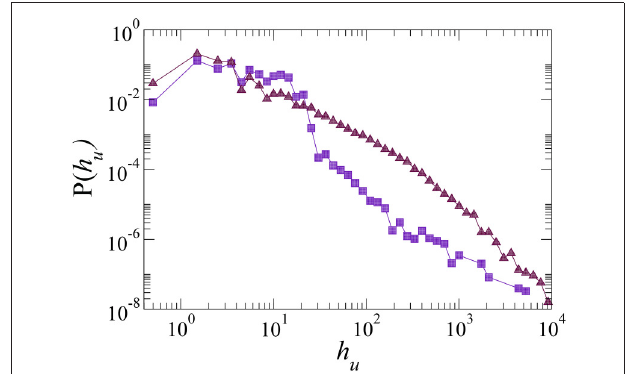
FIGURE 7 | Distribution of ratings in the reviews of EP (dark) and DY (light). Both distributions show a strong bias toward positive ratings, with a moderated